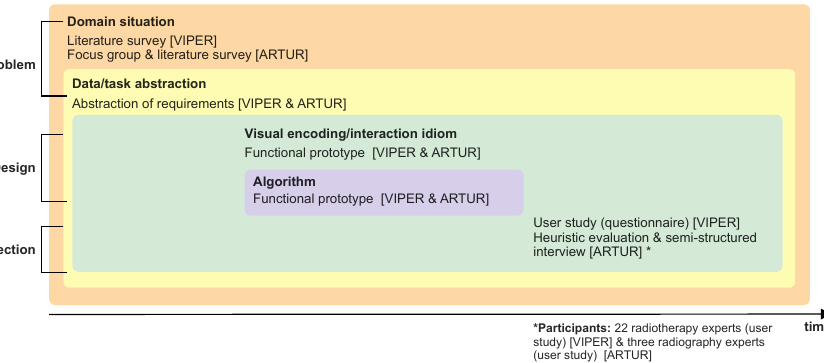
Figure 1. We followed a nested model [16], along with a design study methodology [15]. We started with the problem characterization, including the domain situation and data/task abstraction, followed by the design, with the visual encoding/interaction idiom and algorithm. Finally, we reflect on the results of the conducted user